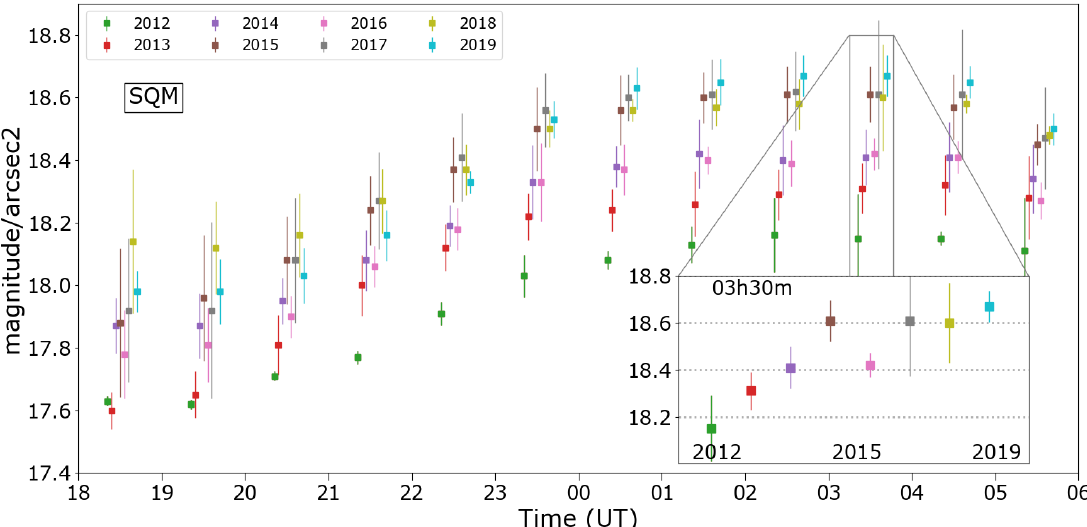
Figure 19. Change in position and shape of the curves showing the evolution of SQM magnitude throughout the night in winter. Data are grouped by year and binned in hourly intervals.